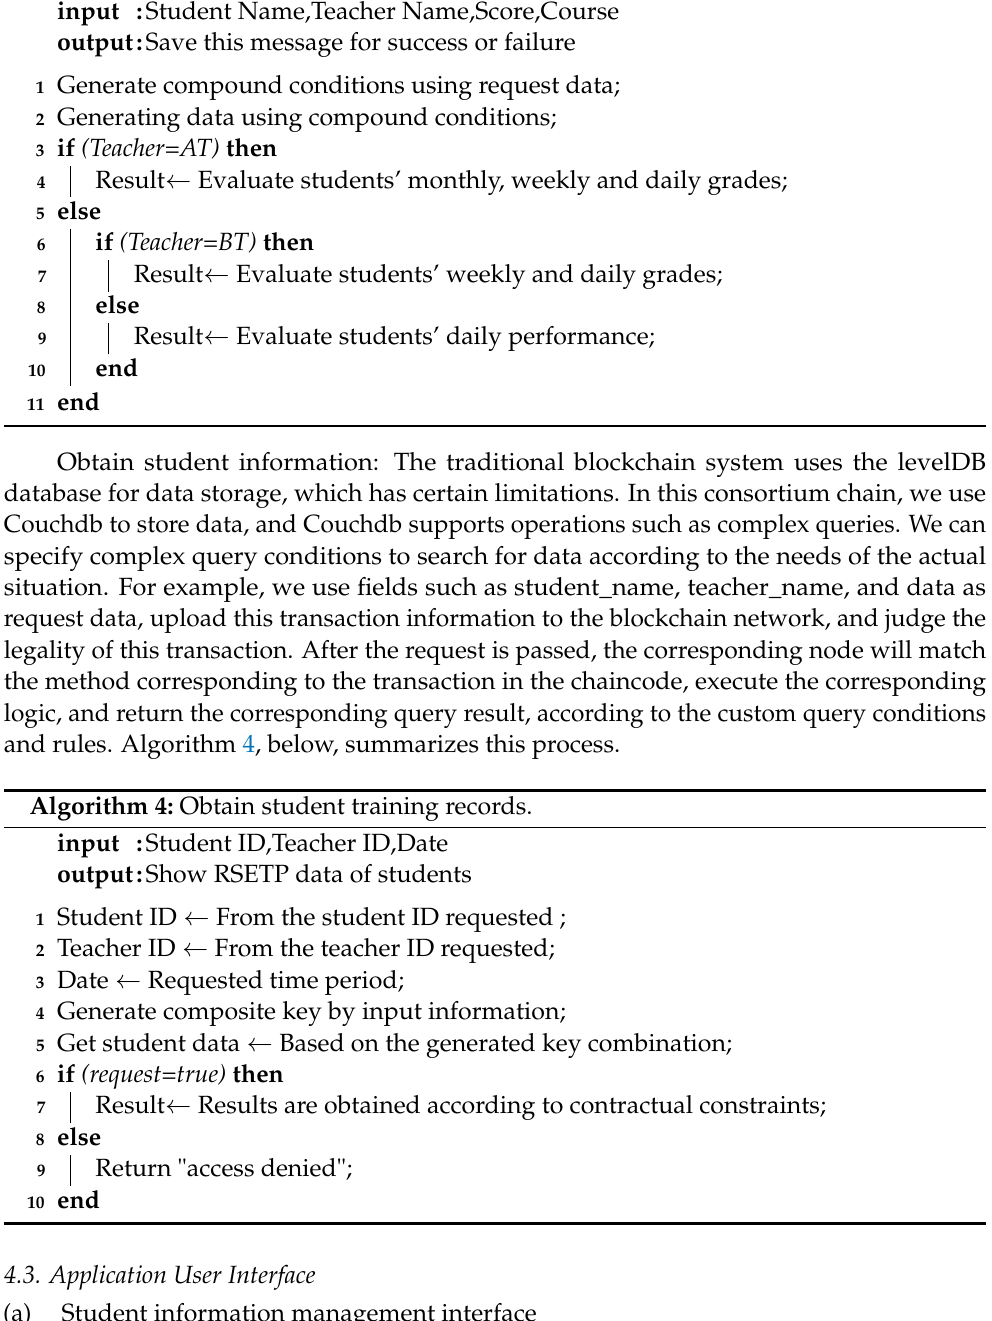
Algorithm 3: Student Assessment Function.